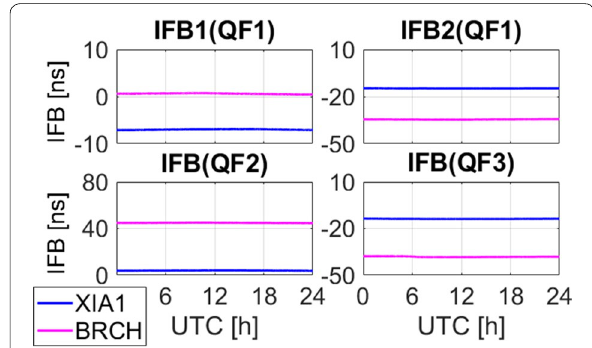
Fig. 7 Time series of IFB in BDS QF1, QF2 and QF3 models at iGMAS stations XIA1 and BRCH on DOY 14, 2019